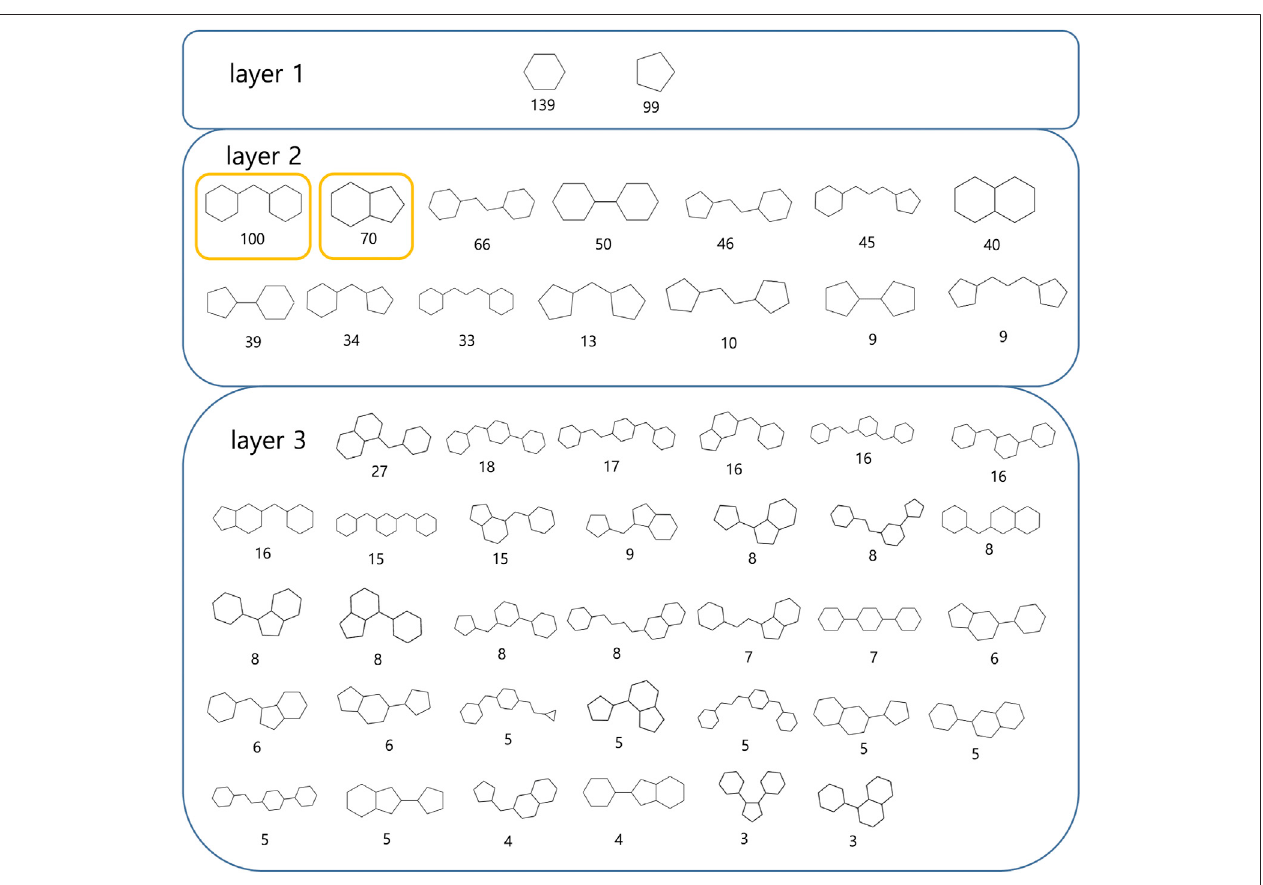
FIGURE 4 | Most frequent CSK from ‘ -tinib ’